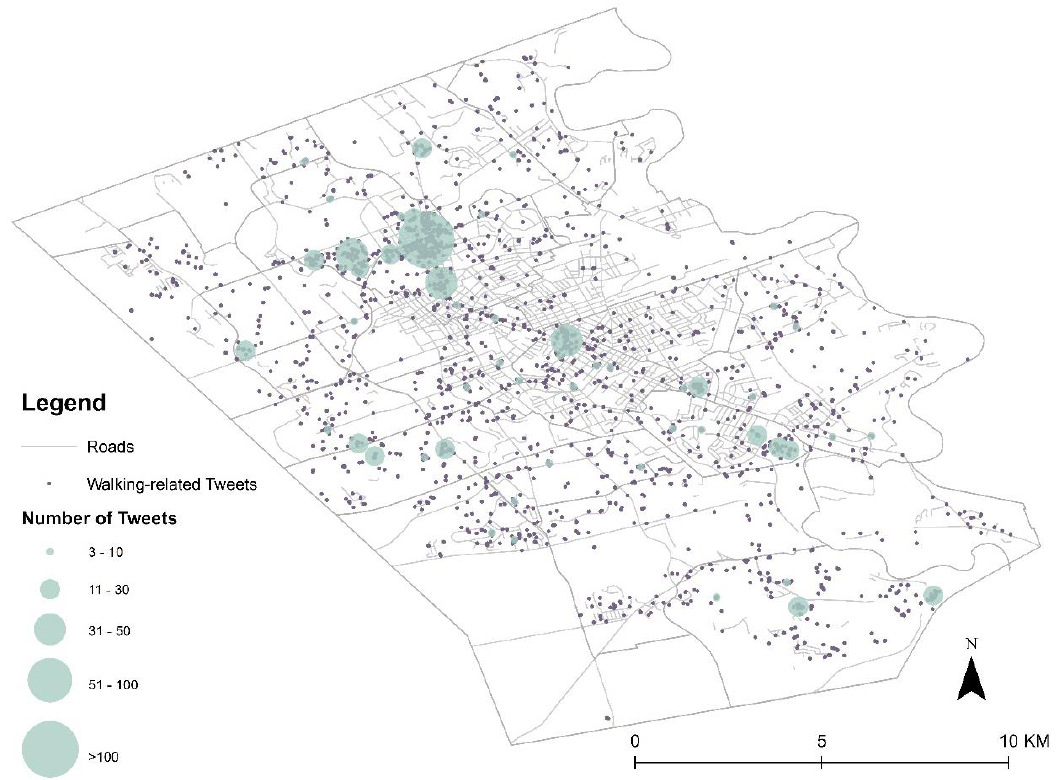
Figure 7. Spatial distributions of public transportation related tweets.